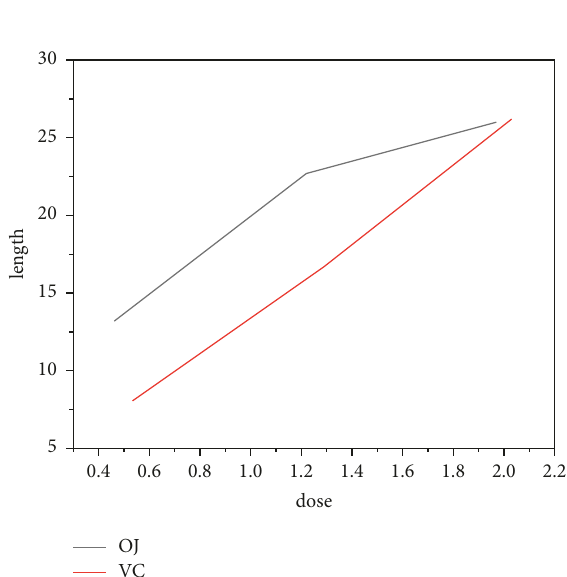
Figure 7: PSO optimized hybrid